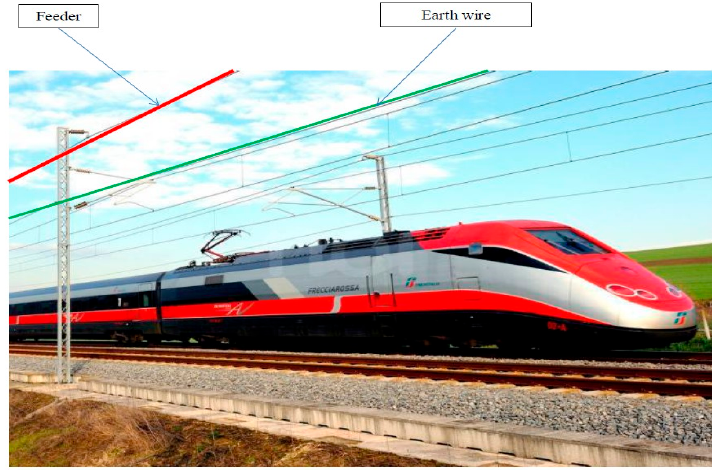
Figure 11. Section of a real High Voltage (HV) line with indication of the feeder and earth wires.